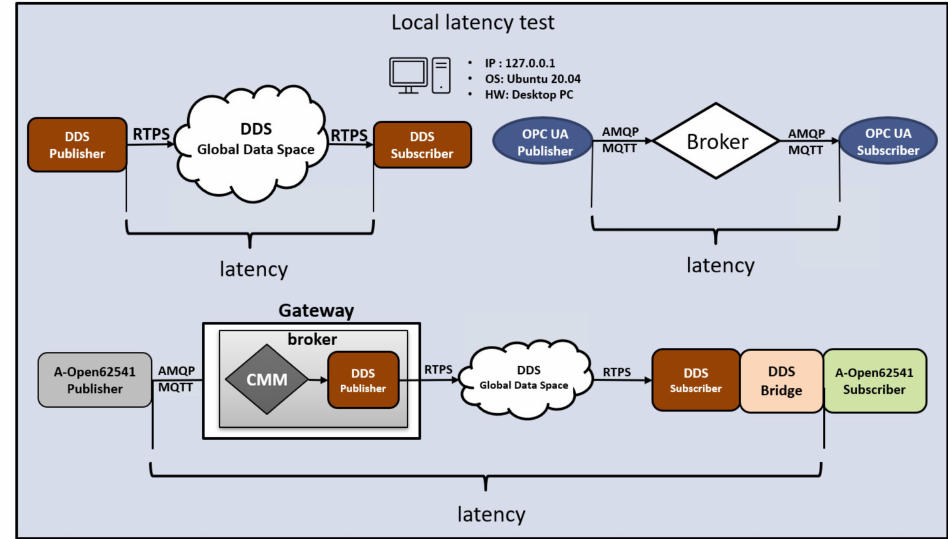
Figure 13. Testbed configuration for the performance analysis.